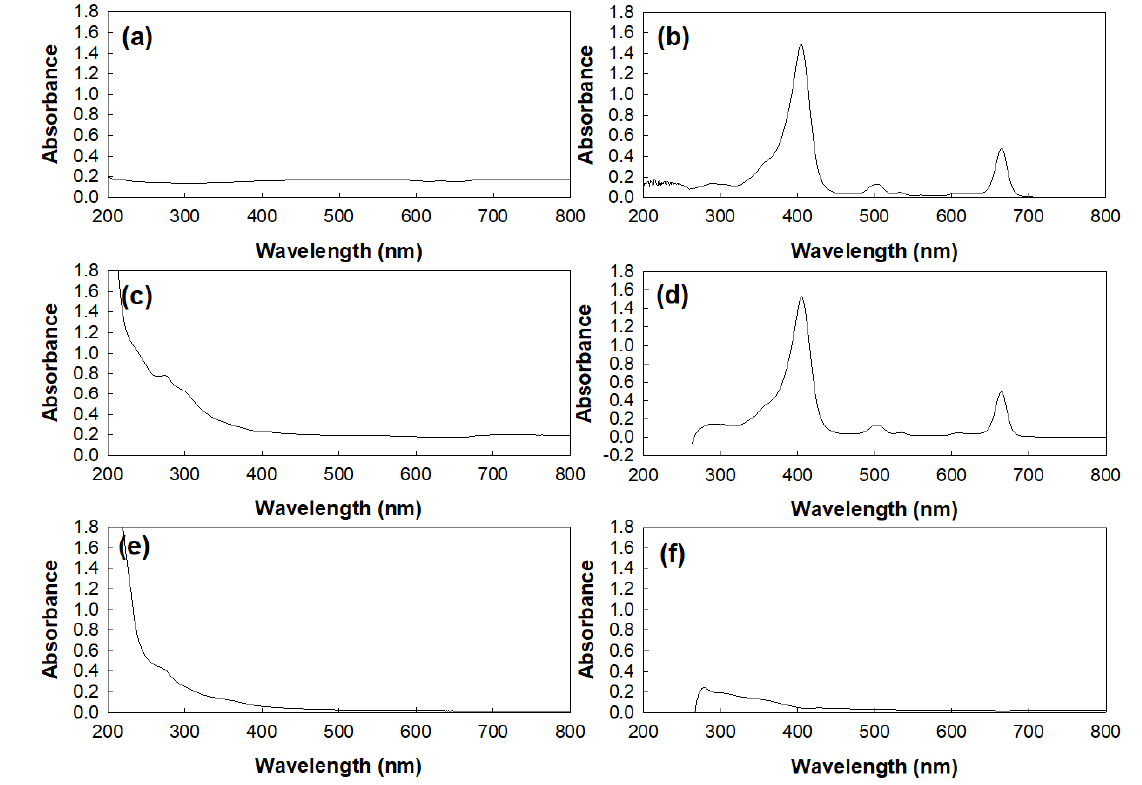
Figure 3. UV absorption spectra of Ce6, nanophotosensitizers, and empty nanophotosensitizers (COSthPBAP). ( a ) Ce6 (0.01 mg/mL) in deionized water (DW); ( b ) Ce6 (0.01 mg/mL) in DMSO; ( c ) nanophotosensitizers (0.01 mg/mL as a Ce6 concentration) in DW; ( d ) nanophotosensitizers (0.01 mg/mL as a Ce6 concentration) in DMSO-DW mixture (9:1, v:v); ( e ) empty nanoparticles (COSthPBAP, 1 mg/mL) in DW; ( f ) empty nanoparticles (COSthPBAP, 1 mg/mL) in DMSO-DW mixture (1:1, v:v).